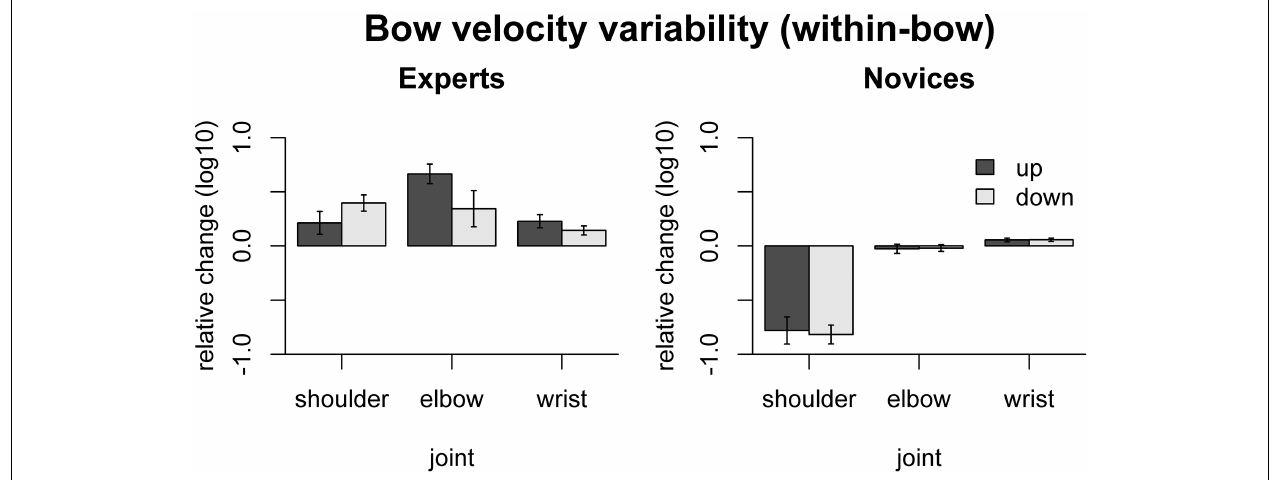
FIGURE 4 | Results of the freezing analysis for within-bow variability of bow velocity (central 80% of the bow movement). Error bars indicate SE across participants.